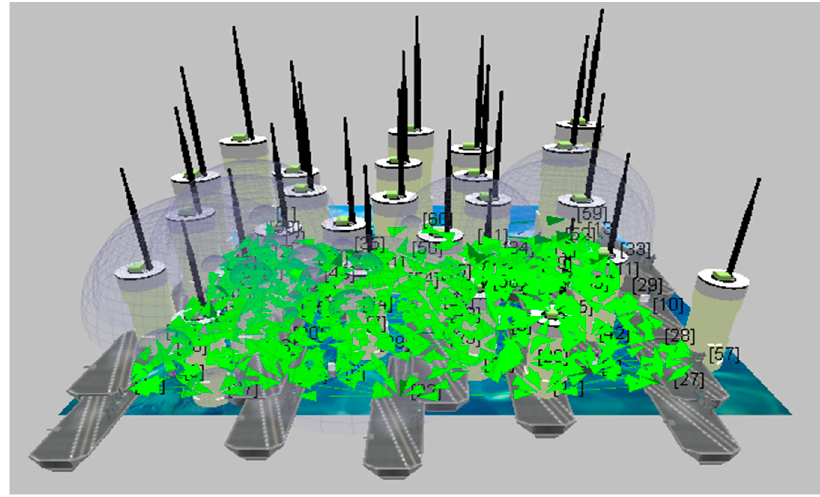
Figure 4. Proposed scenario of underwater wireless communication in X-Y visualization .